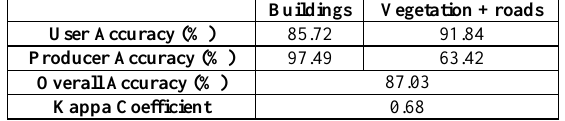
Table 2: Accuracy evaluation of the Marseille test area.